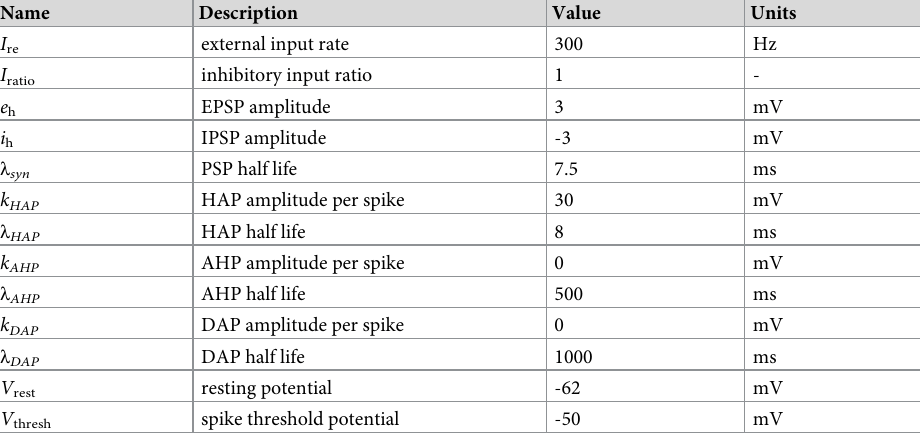
Table 1. Single neuron model default parameters.